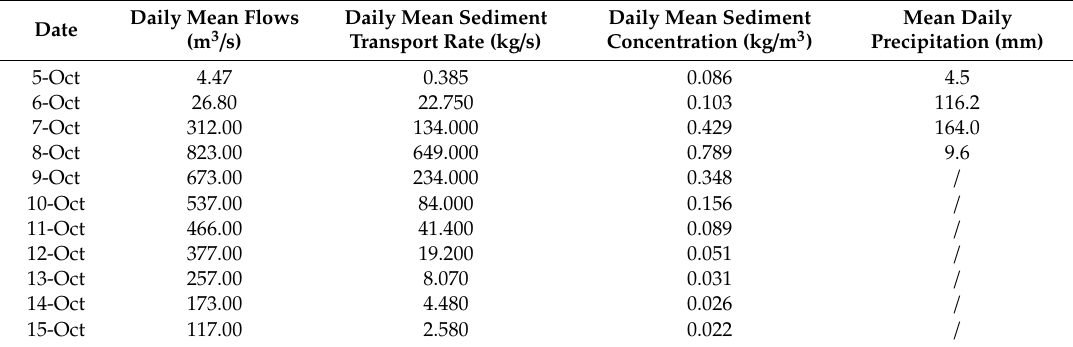
Table 5. The conditions of daily mean flows, daily mean sediment transport rate, and daily mean sediment concentration after heavy precipitation in October 2013.